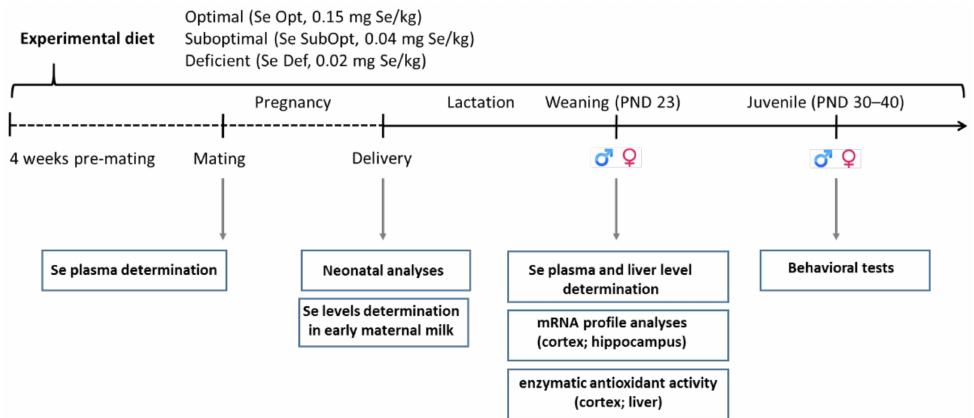
Figure 1. Experimental timeline. Female rats were fed an optimal (0.15 mg/kg), suboptimal (0.04 mg/kg) or deficient (0.02 mg/kg) Se diet from four weeks pre-mating until the end of lac- tation. At weaning, offspring were fed the same diet as their respective dams until completion of the behavioral assessment at PND 40. Neonatal analyses, plasma and tissue collection for Se level determination, biochemical, molecular analyses, and juvenile behavioral tests were performed at the time points indicated. Se, selenium; Se Opt, Se-optimal; Se SubOpt, Se-suboptimal; Se De, Se-deficient; PND, postnatal day; , females; , ♀ ♂